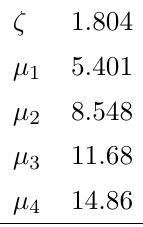
Table 3 . Values for the parameters (cid:16) and (cid:22) i (cid:20) 4 with N = 5 and m 2 by the method explained in appendix